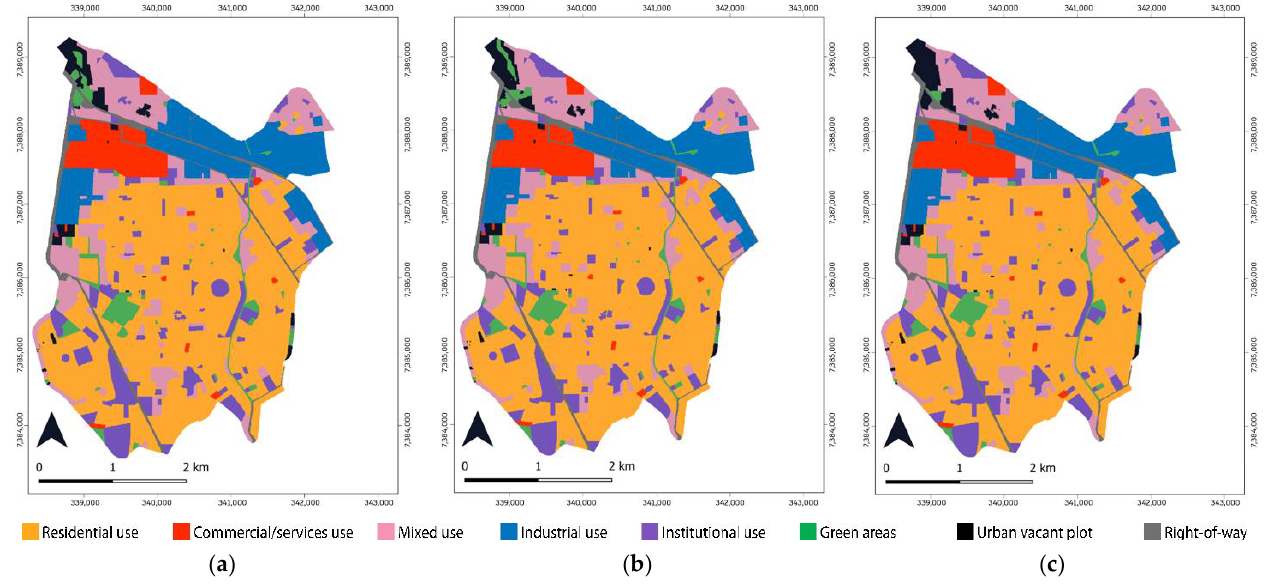
Figure 15. Simulated land use maps for the different scenarios: ( a ) Scenario 1 — Natural Development, ( b ) Scenario 2 — Urban Diversification, ( c ) Scenario 3 — Business as Usual.